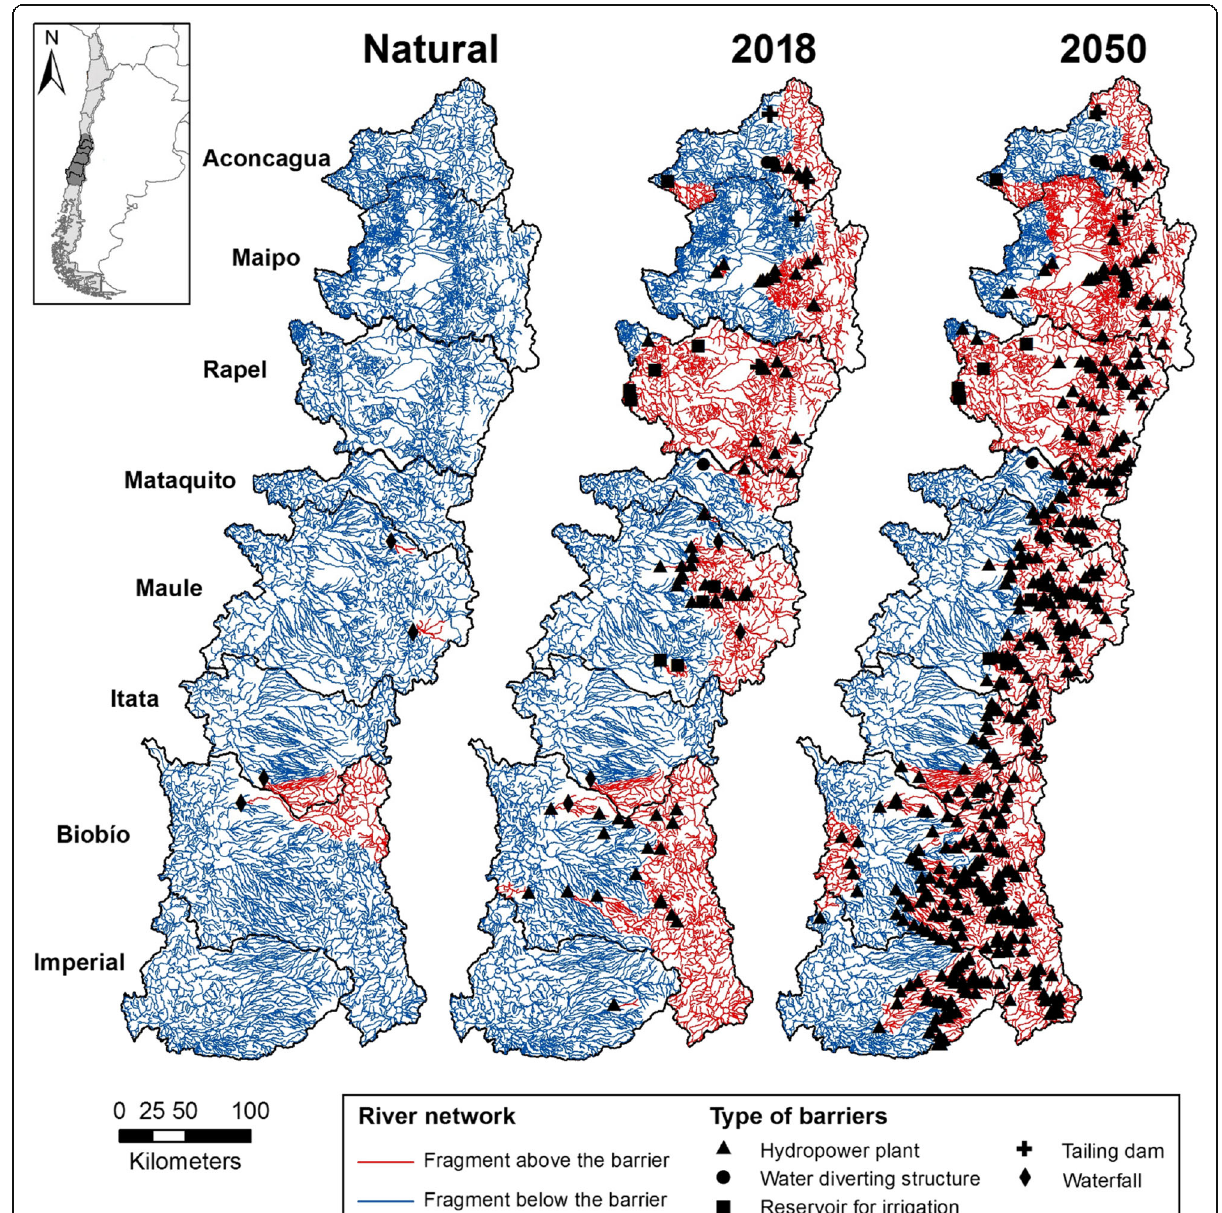
Fig. 4 Natural, current (2018) and future (2050) fragmentation scenarios of analysed river